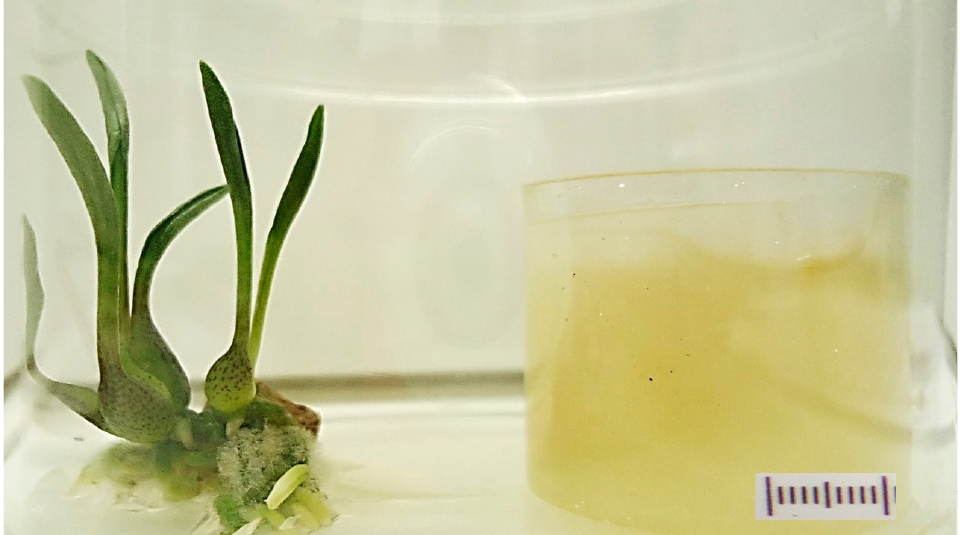
Figure 1. Container with lily scale explants on a nutrient medium with 3% sucrose and a vial of KOH to remove CO 2 . Bar = 10